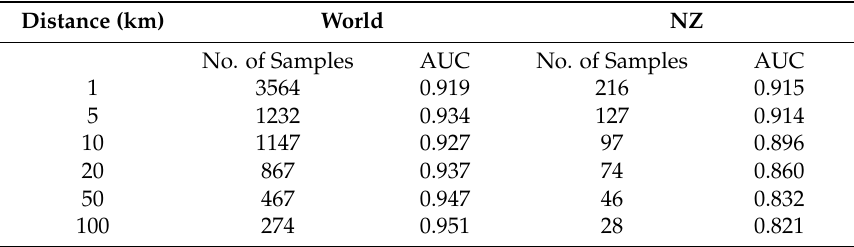
Table 1. Area under the curve (AUC) values of different rarefication values for worldwide and New Zealand Erigeron species distribution to identify correlated environmental